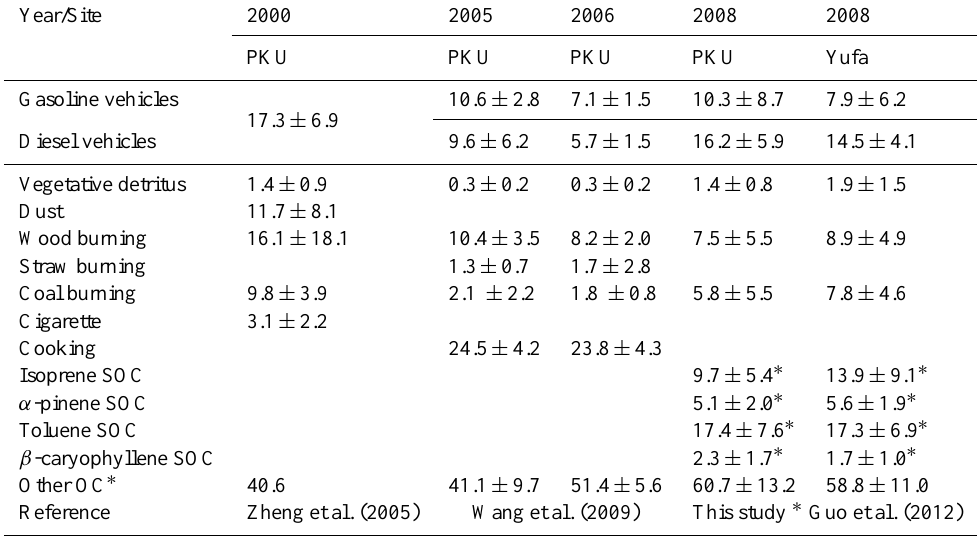
Table 3. Comparison of summertime source contributions to measured PM 2 . 5 OC in Beijing, average ± standard deviation